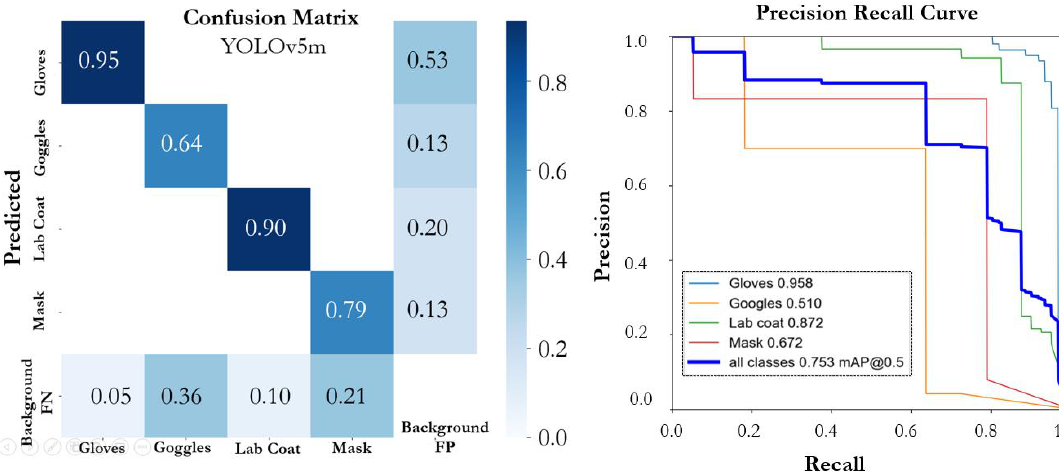
Figure 10. Confusion matrix and PR curve of the YOLOv5m model.